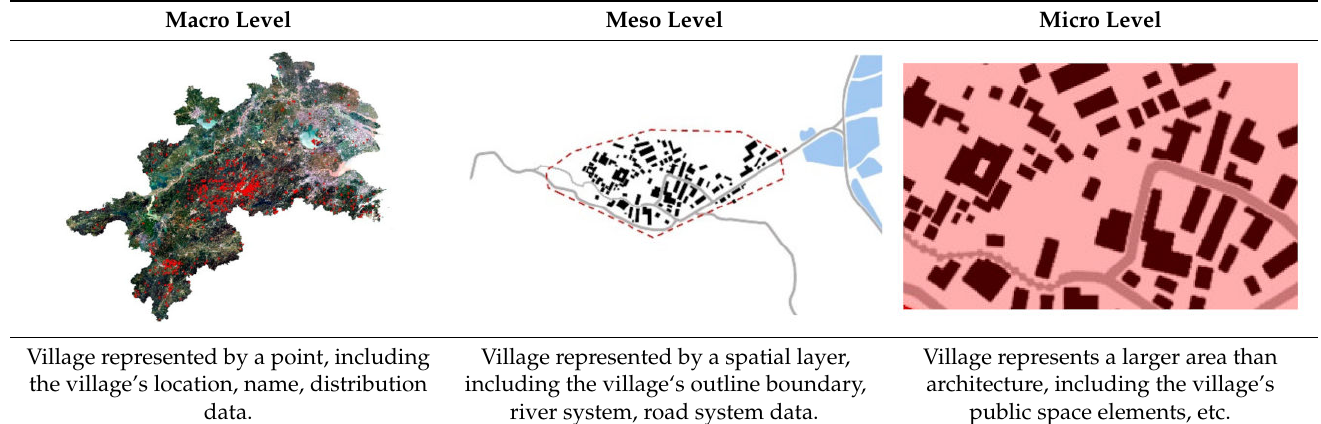
Table 4. The different village spatial data obtained from different levels in ArcGIS: edited by authors. Macro